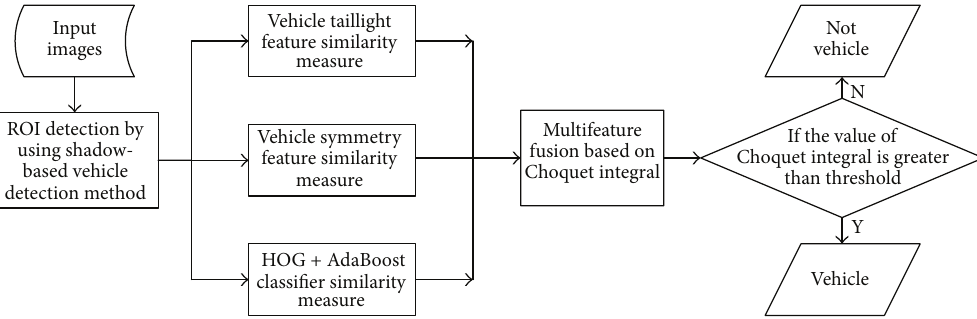
Figure 1: Framework of our approach.